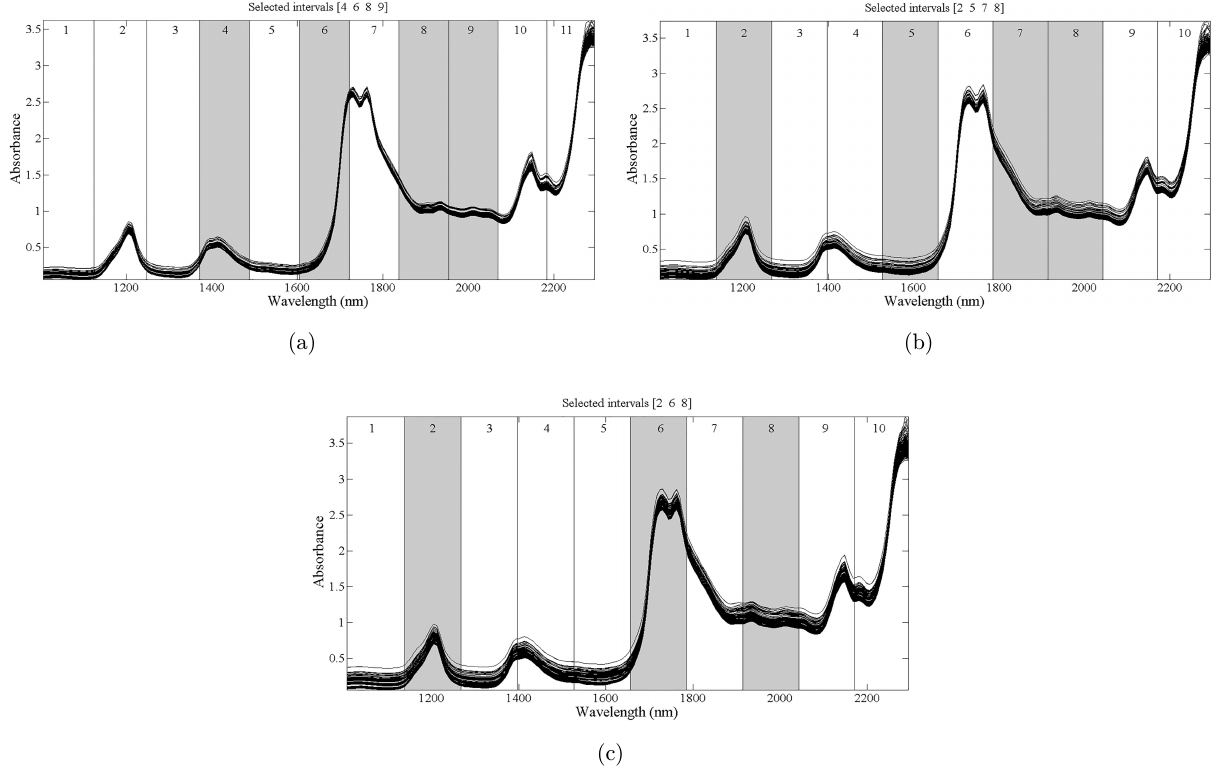
Fig. 2. The intervals used for the three SI-PLS models: (a) the intervals used for sun°ower oil identi¯cation model, (b) the intervals used for peanut oil identi¯cation model, and (c) the intervals used for corn oil identi¯cation